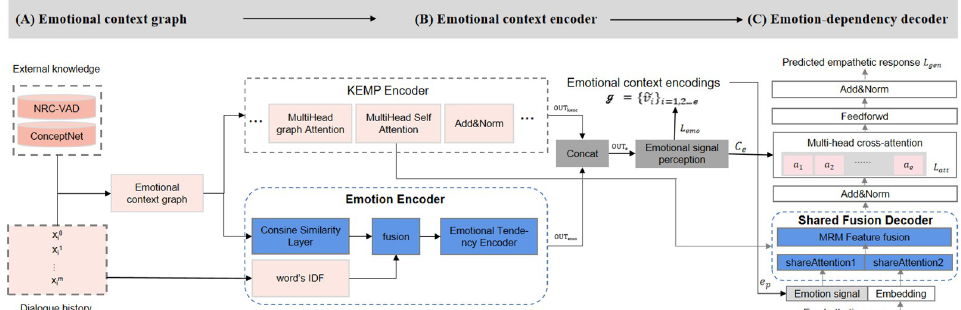
Fig 3. EMO_SA’s architecture diagram. It is composed of an emotional context graph, an emotional context encoder, and an emotion-dependency decoder. Compared with the original KEMP model, we mainly added an emotion encoder of the same level as the KEMP encoder and a shared fusion decoder to the emotion-dependency